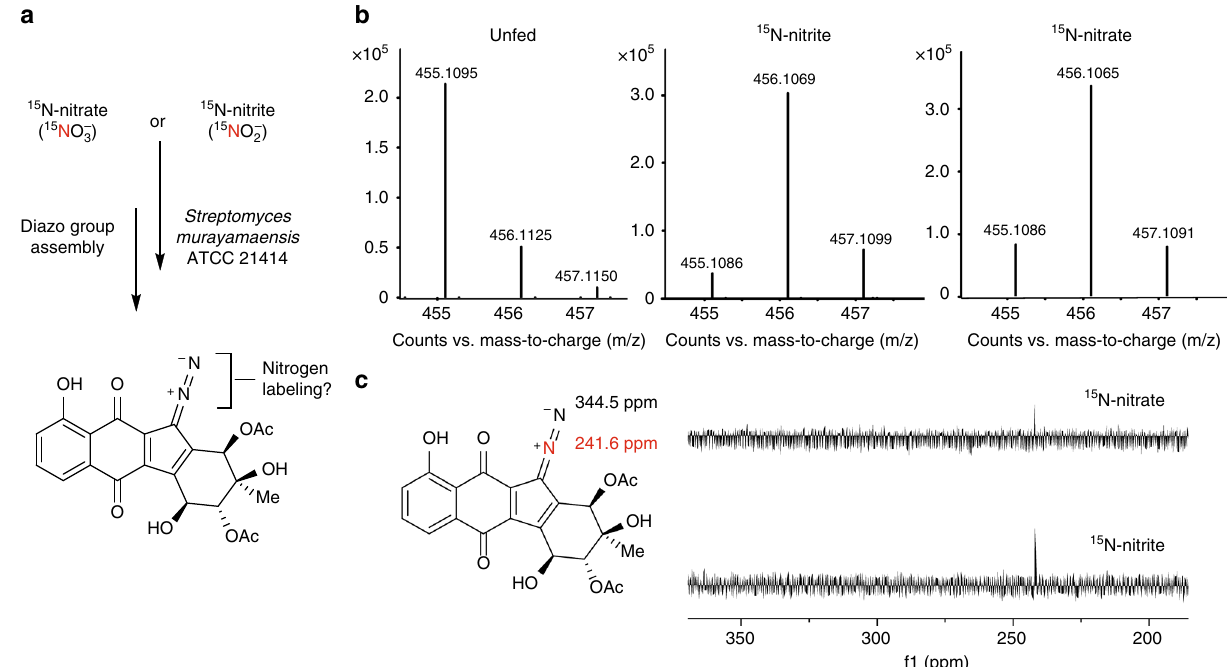
Fig. 3 15 N-incorporation into kinamycin D by inorganic nitrogen sources. a Scheme for feeding experiments with S. murayamaensis using 15 N-labeled nitrite and nitrate. b HRMS analysis of 15 N incorporation into kinamycin D when no labeled nitrogen-containing salts, 1 mM 15 N-nitrite, or 1 mM 15 N-nitrate, were added to the fermentation culture of S. murayamaensis . The calculated m/z ([M + H] + ) for kinamycin D at natural abundance is 455.1091, 15 N-kinamycin D is 456.1055, and 15 N 2 -kinamycin D is 457.1026. c 15 N NMR analysis of kinamycin D isolated from fermentation cultures of S. murayamaensis revealed that 15 N-nitrate and 15 N-nitrite labeled the proximal nitrogen of the diazo group (highlighted in red)